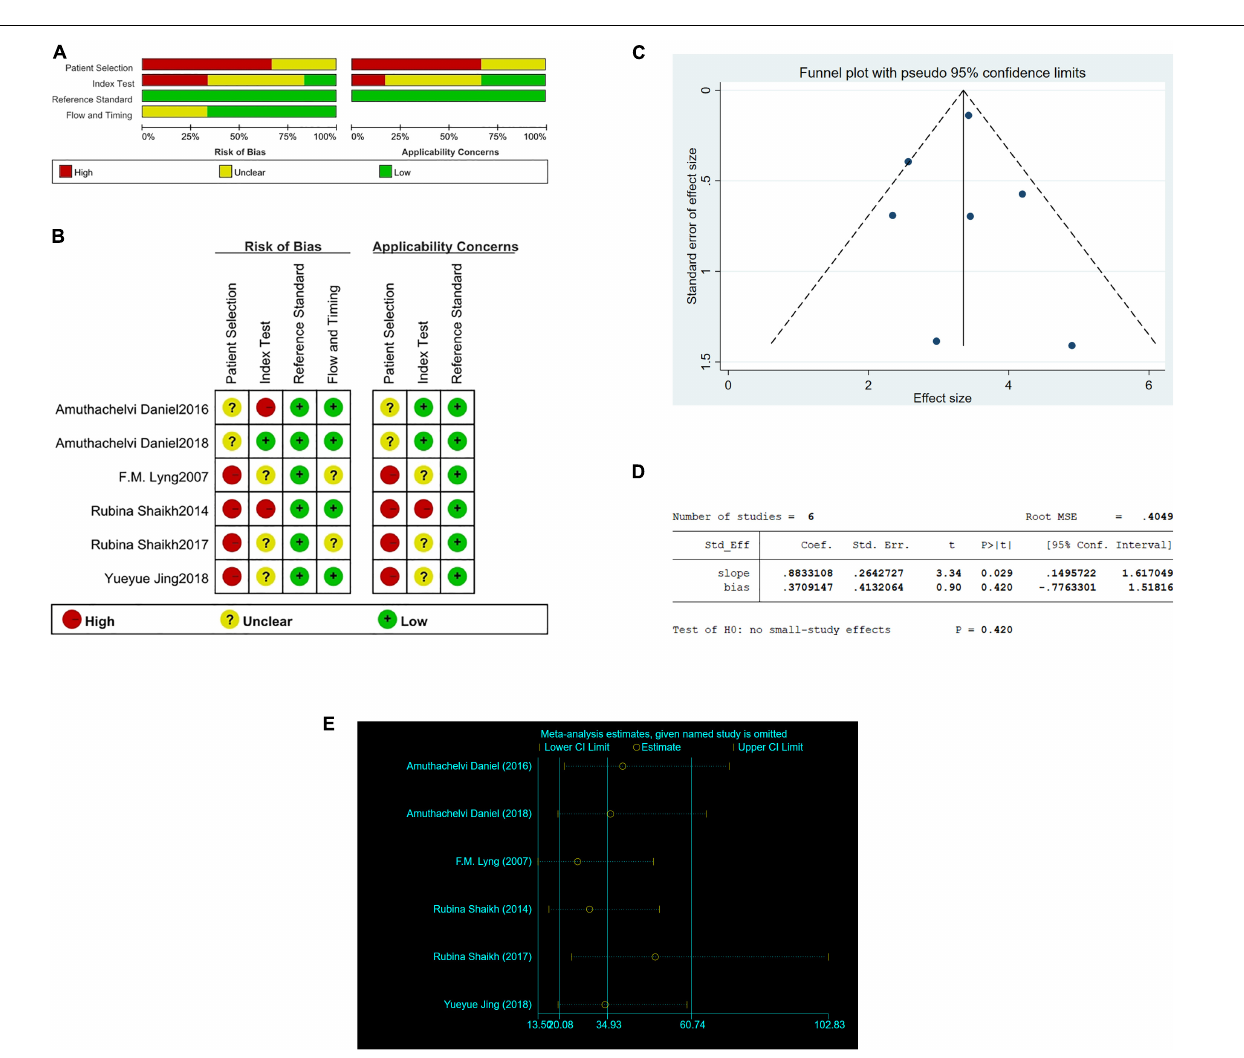
Frontiers in Medicine |